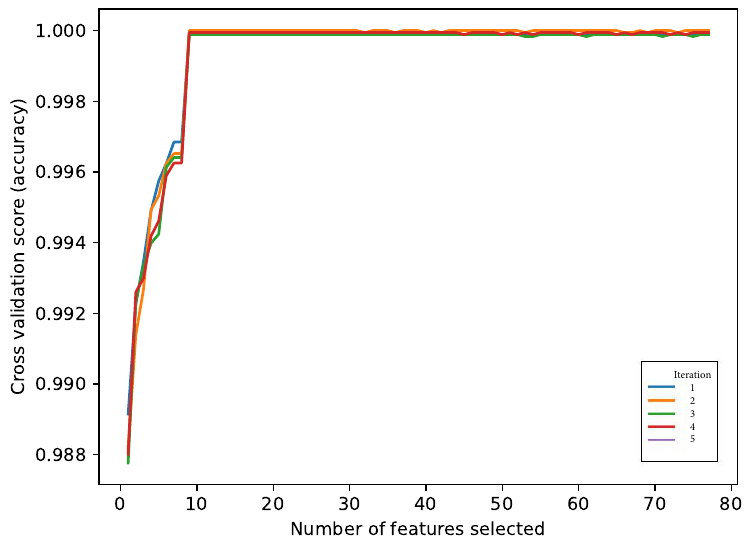
Figure 2. Accuracy versus variable